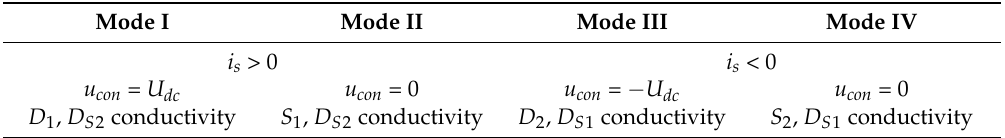
Table 1. Four operation modes of bridgeless rectifiers.